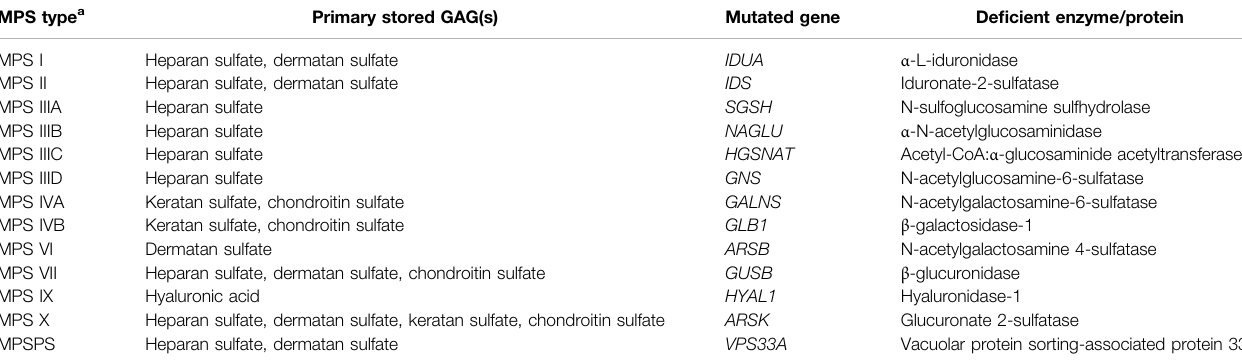
TABLE 1 | Types of mucopolysaccharidoses